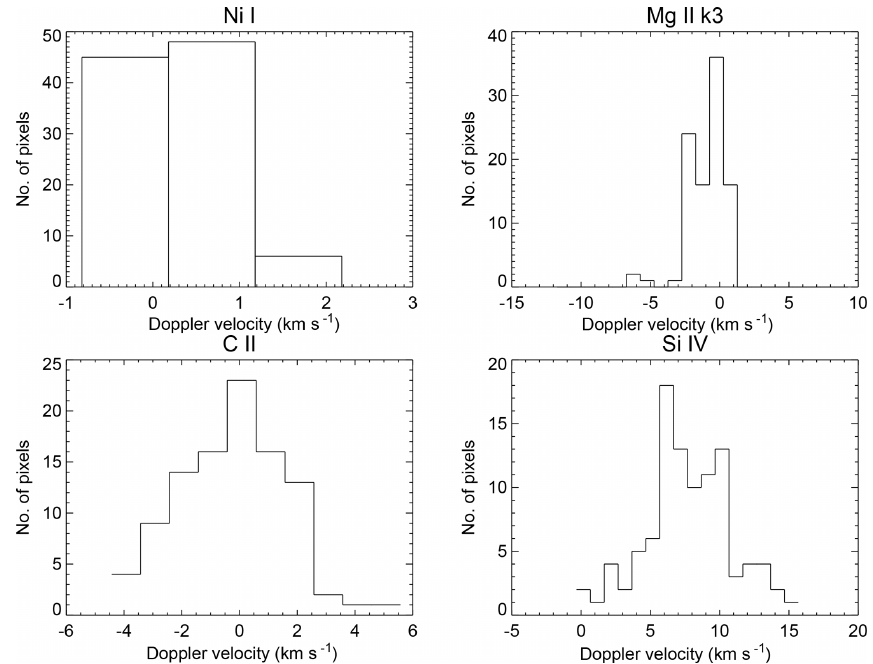
Figure 6. The velocity distributions for different spectral lines corresponding to different temperatures at box B1.